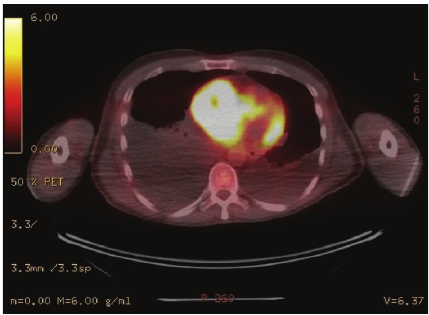
Figure 1: PET/CT scan displaying metastatic masses in right atrium and liver, as well as bilateral pleural effusion due to heart failure.